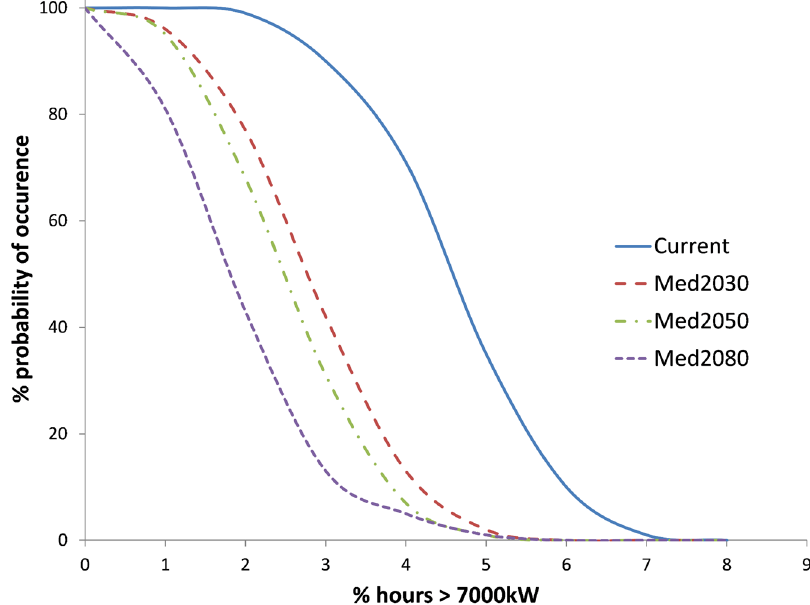
Figure 7. Result of future probabilistic heating load assessment of case-study